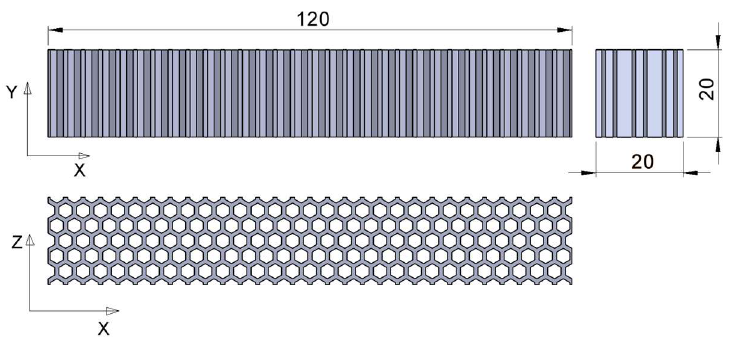
Figure 5. The specimens’ overall dimensions—illustration for the hexagonal